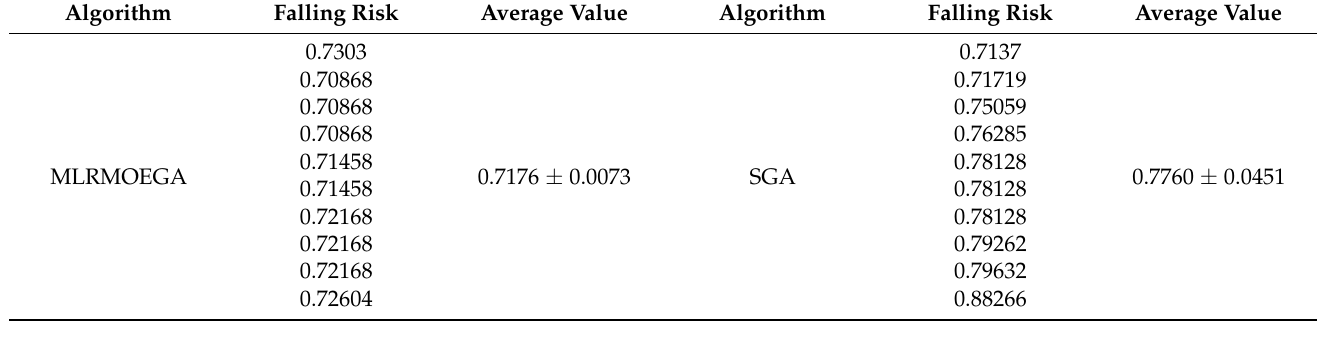
Table 4. Results of Artificial Potential Field Theory Experiment (with 30 × 30 grid map).